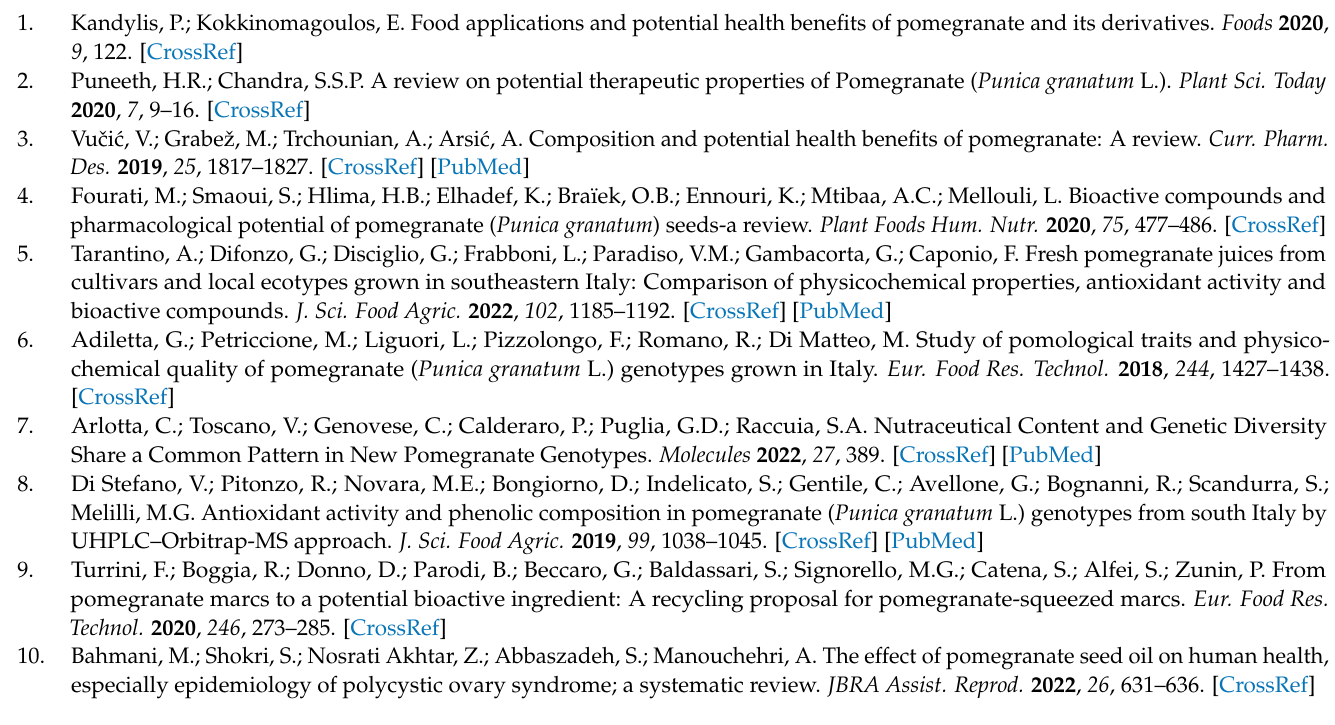
Figure S4. 1 H and 13 C NMR inverse gated of transesterified scCO 2 oil 2a ; Figure S5. Differences in the polyphenolic content of SPE Soxhlet oil, 1b and scCO 2 oil,